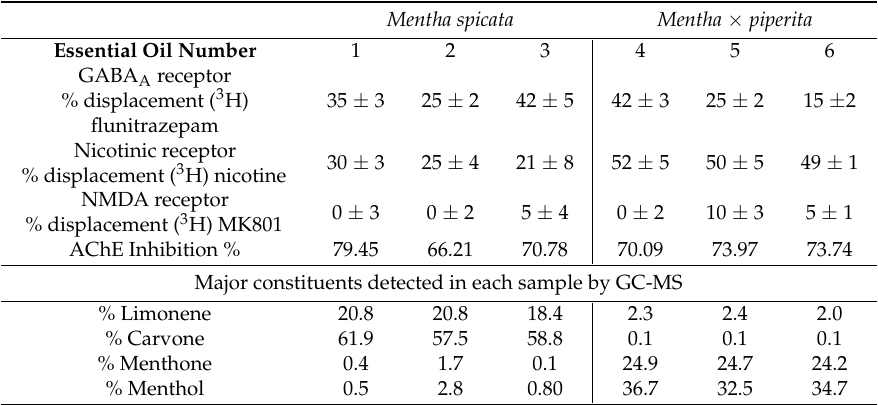
Table 1. Results from the initial screening of essential oils (receptor binding at a concentration of 0.1 mg/mL) and major constituents detected in each Mentha species by GC-MS analysis. Mentha spicata Mentha ×